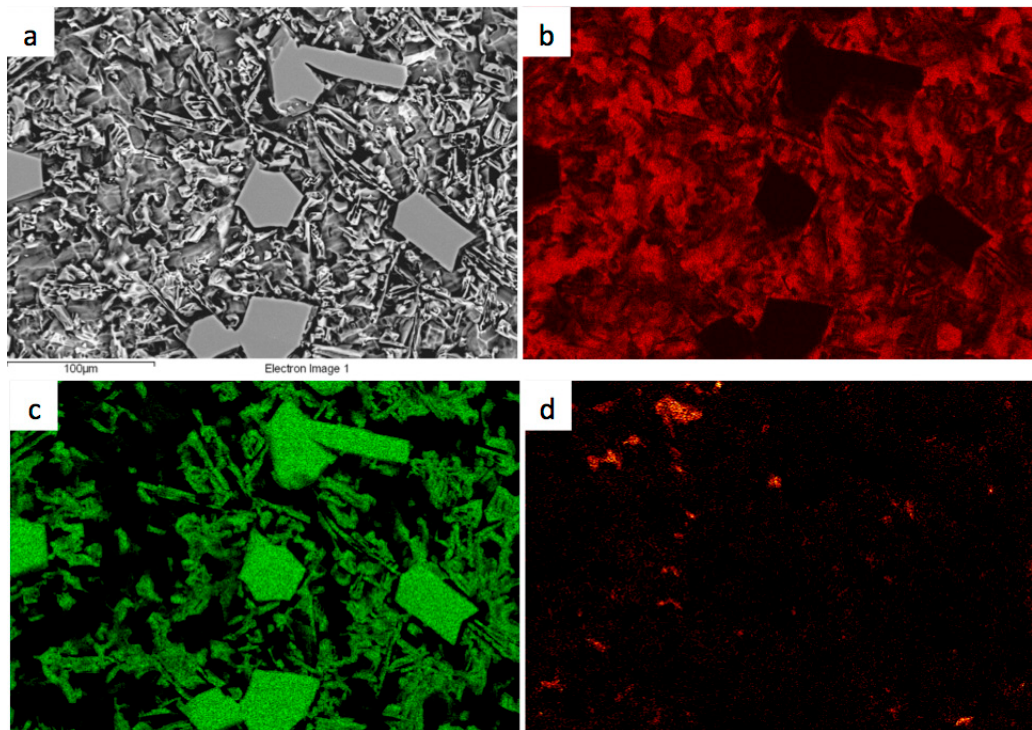
Figure 3. ( a ) SEM image of solidification microstructure and EDX maps of principal allying elements ( b ) Al, ( c ) Si and ( d ) Cu for the conventionally cast Al-18%Si-2%Cu alloy.